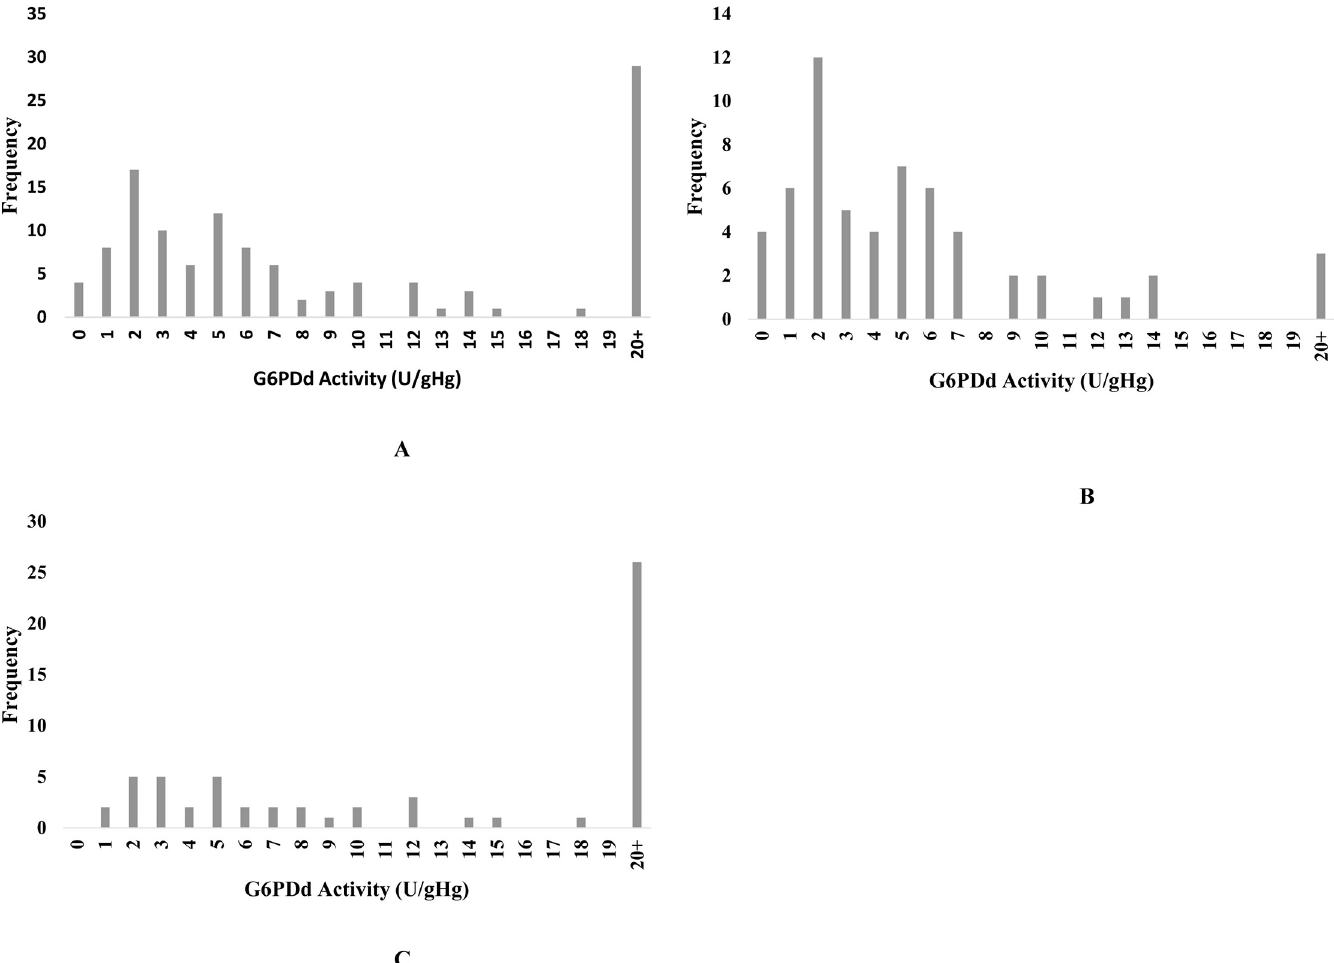
Fig 3. Distribuition of the G6PD activity in Cabo Verde, in according to gender. A—Distribuition in the general population. B in the male population and C in the female population.